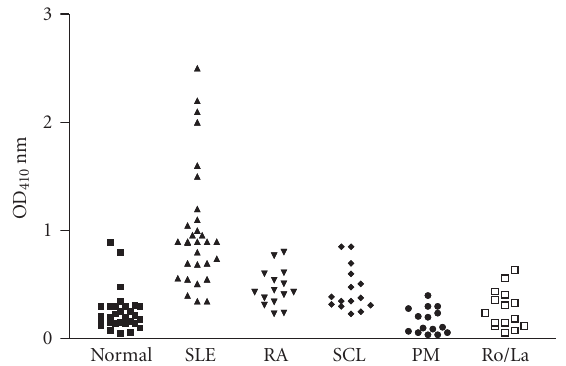
Figure 8: Reaction of SLE sera and control sera with the peptide. The sera were diluted 1/100 in PBS and added to peptide-coated ELISA plates and the reaction of sera antibodies with the peptide were detected by goat antihuman IgG Fc fragment specific alkaline phosphatase conjugate. The 30 SLE sera and the control sera include 14 rheumatoid arthritis, 12 polymyositis dematomyositis, 14 sclerodema, 15 Ro/La positive sera, and 30 normal sera. The mean reading of 30 SLE sera bound with peptide was statistically di ff erent from that of control sera ( P < . 0001 by unpaired t -test).